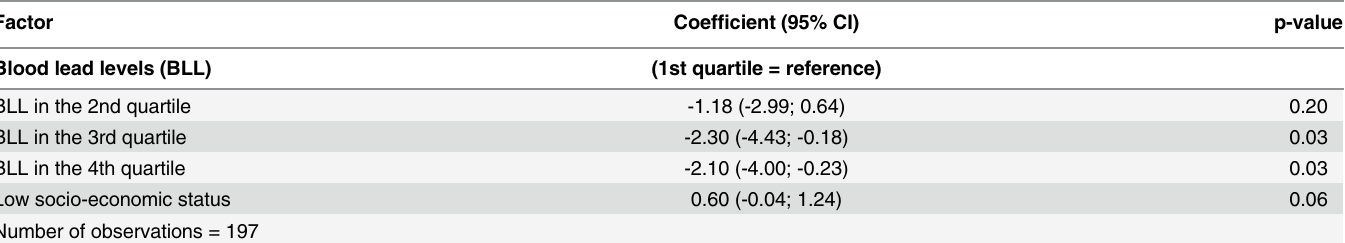
Table 4. Negative binomial regression on factors associated with P . falciparum density (logarithm of parasite density at lead assessment). Factor